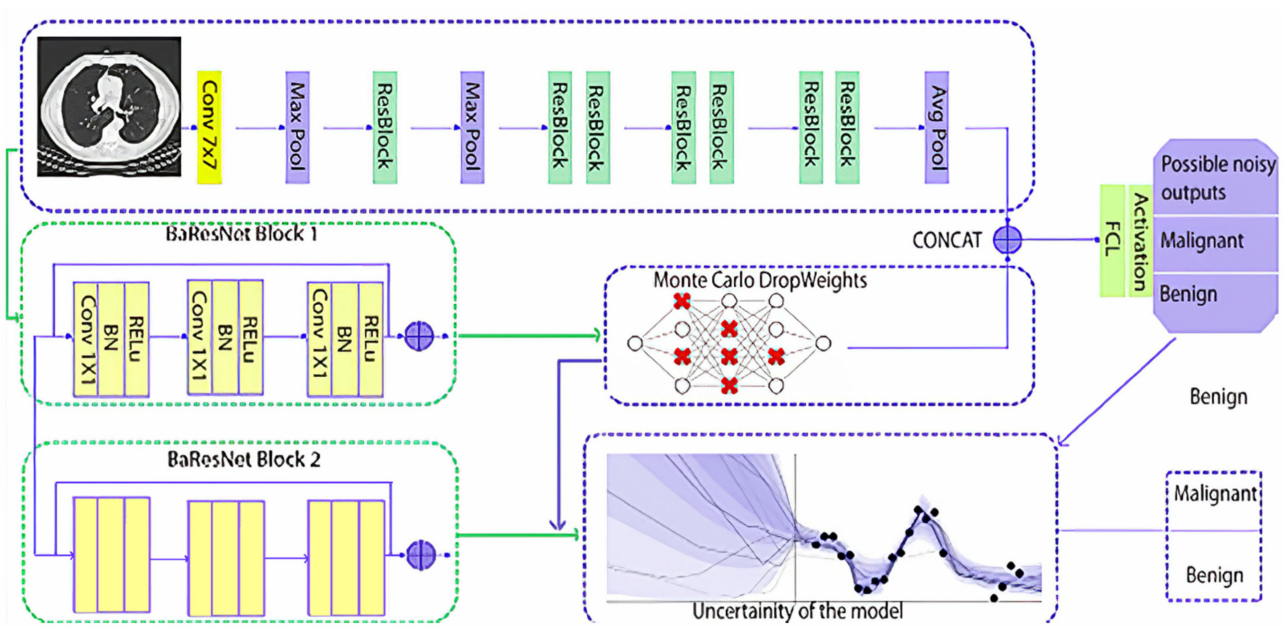
Figure 3. Proposed Baresnet model architecture: A study on uncertainty quantification in lung cancer